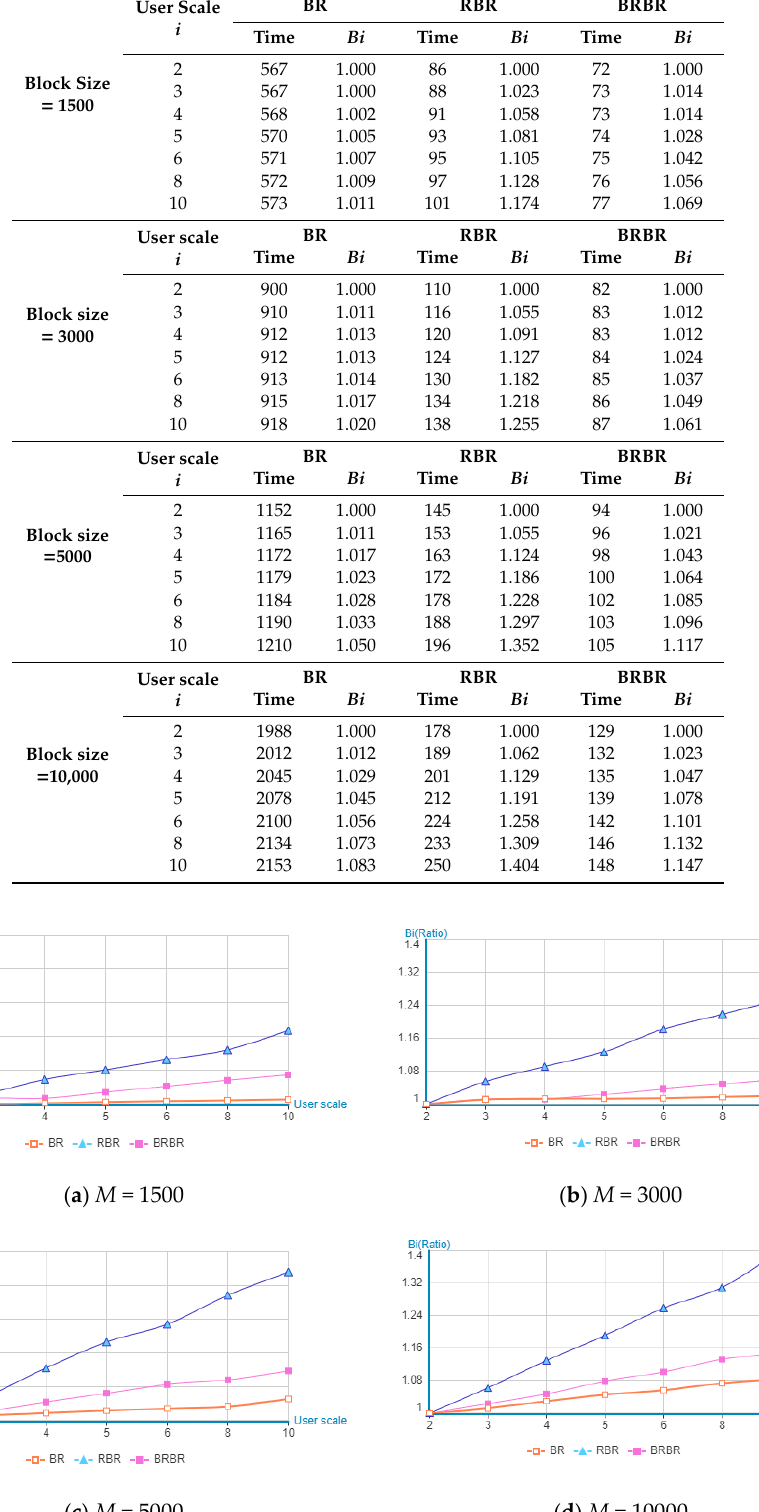
Table 4. Comparison of retrieval time under di ff erent user scale (unit: ms).